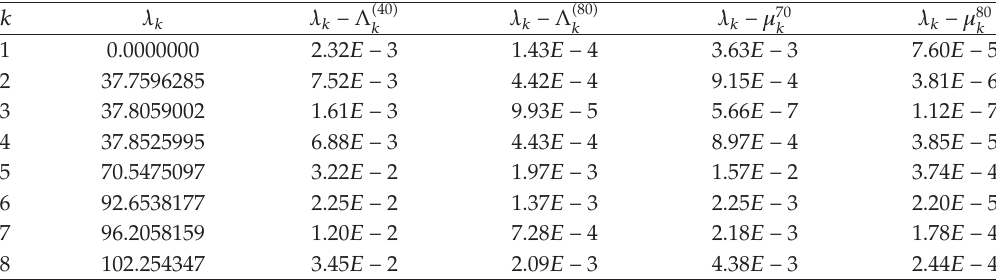
Table 7: Comparison of the exact eigenvalues with approximate eigenvalues obtained from Numerov’s method (cid:2)Λ k (cid:3) with correction and TDM (cid:2) μ k (cid:3) for Example 3.3 corresponding to β (cid:5)